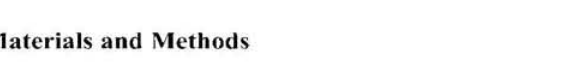
Pteridines/Vol. 17/No.